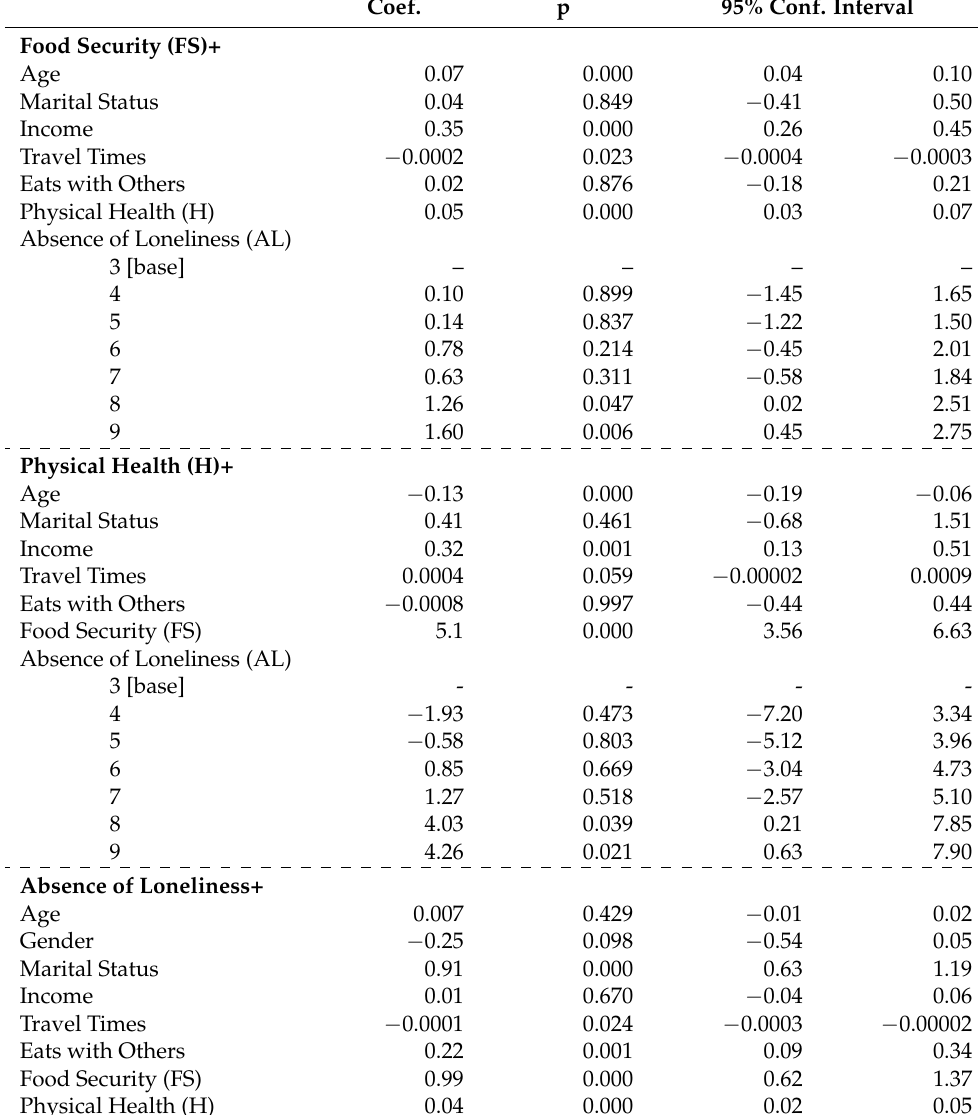
Table A1. Before COVID structural equation modeling